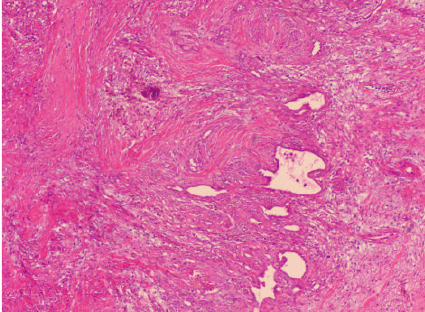
Figure 3: Low power view of tumour with glandular spaces lined by epithelial cells in a background of plump spindle cells with stromal calcification (Haematoxylin and eosin, × 4).